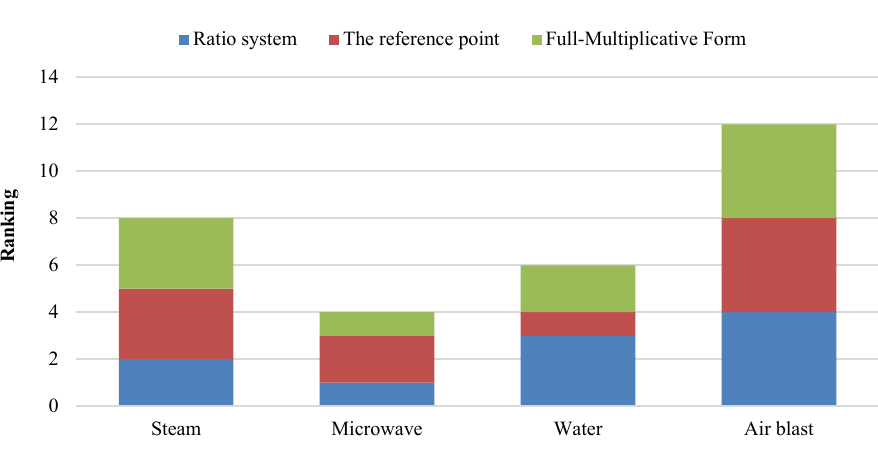
Fig. 3. Evaluation of MULTIMOORA